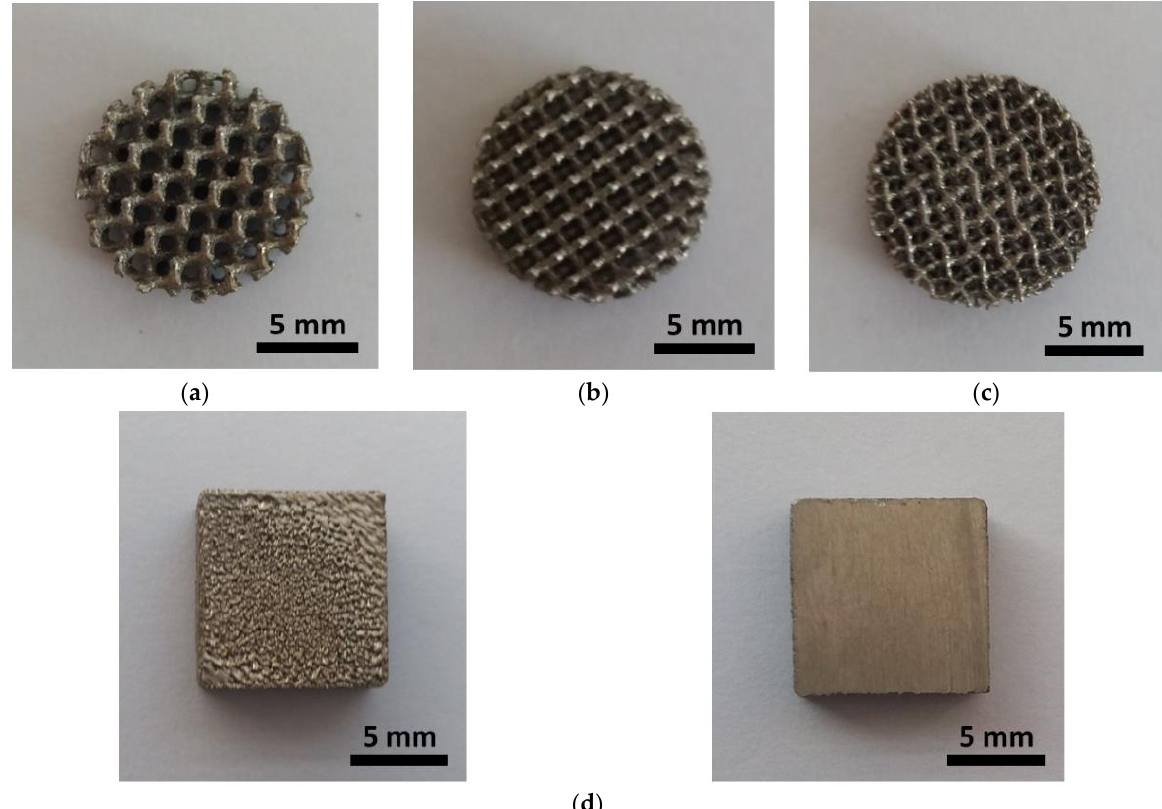
Figure 4. CpTi G2 produced by SLM: ( a ) G80 cellular lattice; ( b ) D80 cellular lattice; ( c ) I-2Y80 cellular lattice; ( d ) Bulk specimen in general view (left) and cross-sectional view (right).